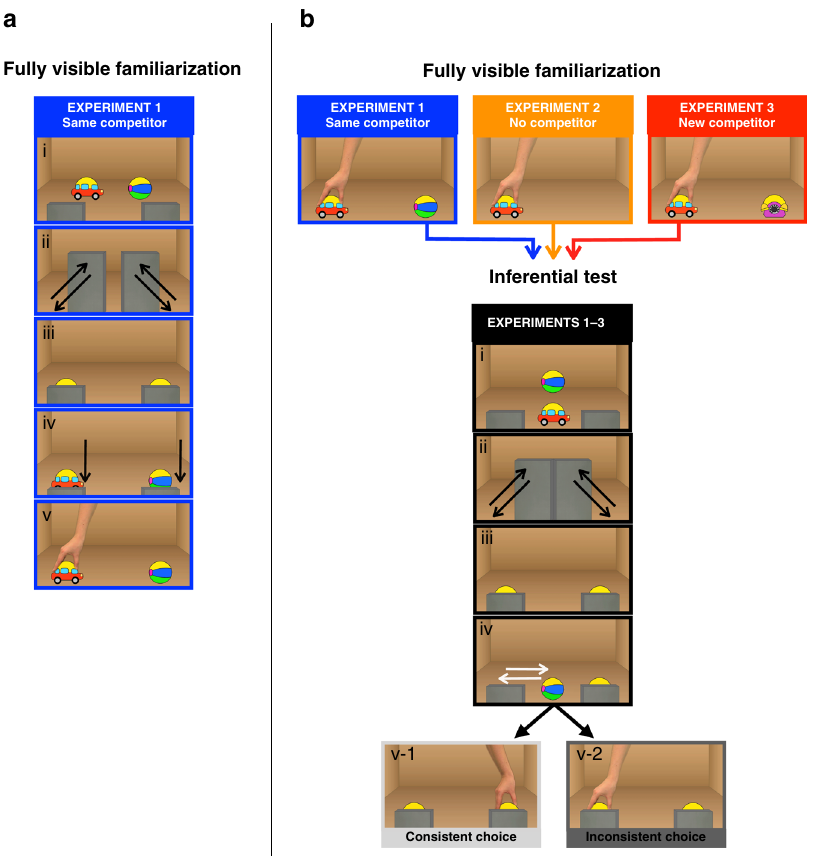
Fig. 1 Experiments 1 – 3. Structure of the familiarization and the test movies. a Familiarization events from Experiment 1, where infants saw hiding/ revealing events (i – iv) followed by actions toward a fully visible object (v). b The identical test events of Experiments 1 – 3 preceded by a different familiarization. Experiment 1: the objects used in familiarization were the same ones then used in the test (a toy car and a ball). Experiment 2: only the grasped object was present in familiarization (either the car or the ball). Experiment 3: the competitor-object (a toy telephone) used in familiarization